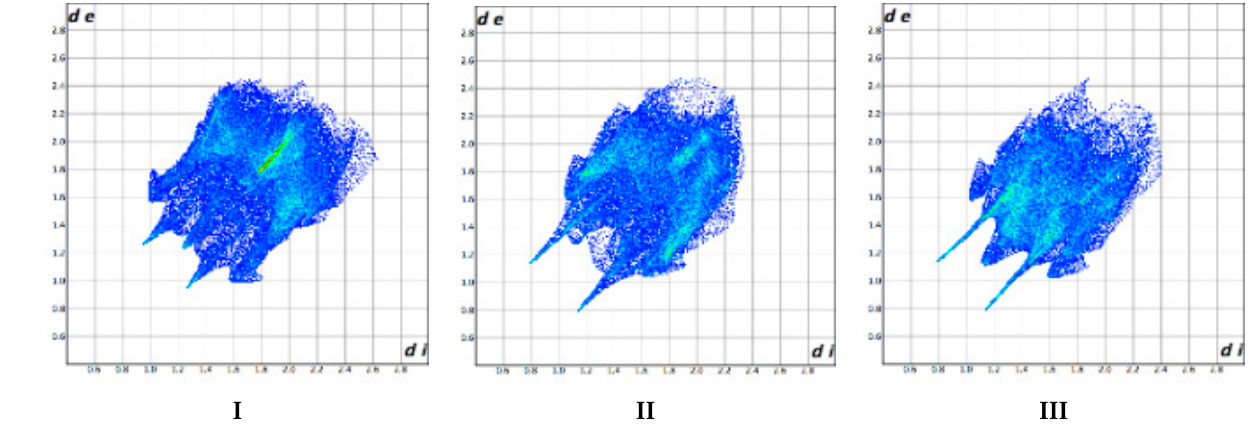
Figure 7. Hirshfeld surfaces of compound I - III mapped over d norm .